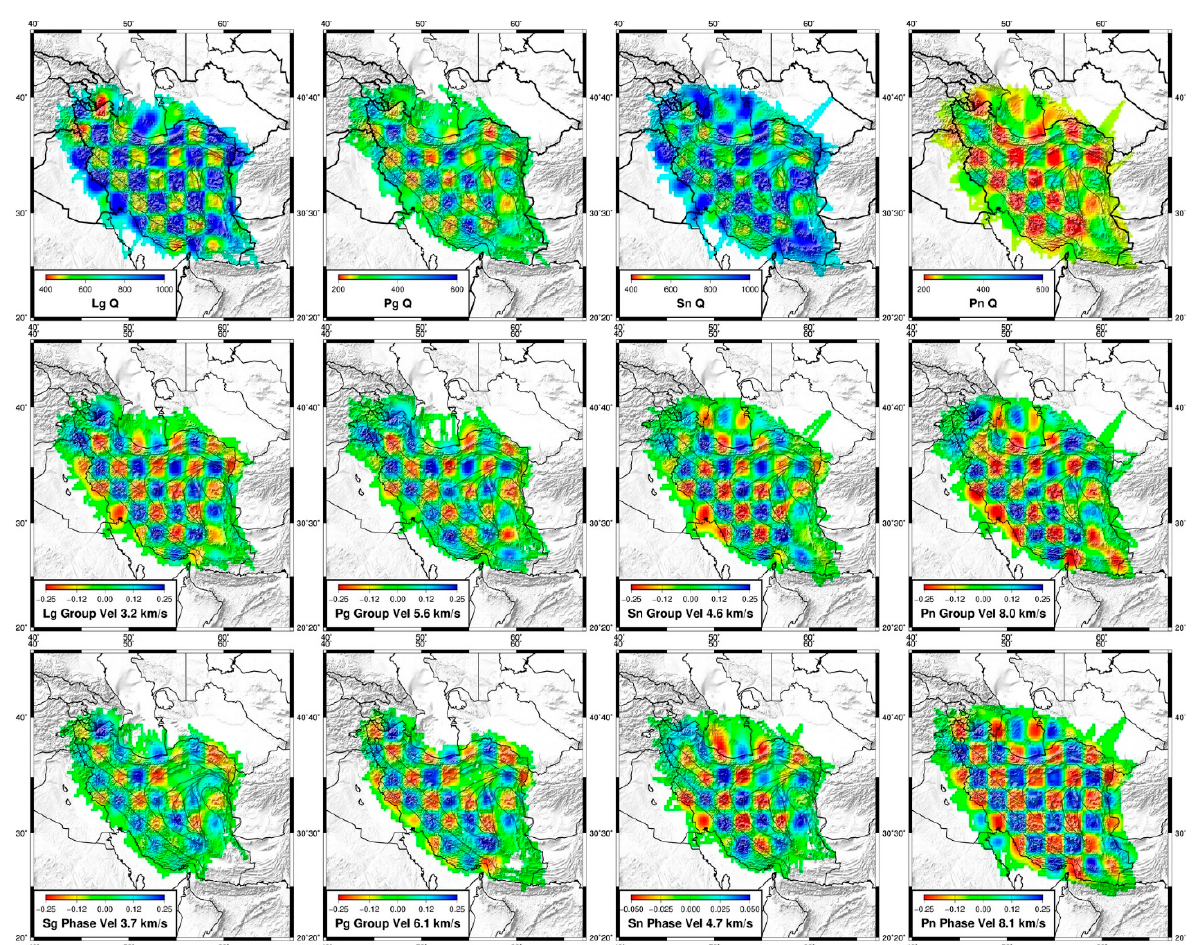
Figure 6. Checkerboard tests of velocity and attenuation. The original checkerboard had attenuation and velocity squares of two-by-two degrees. The station and event delays also alternated every two degrees. Representative noise was added. Velocity squares are ± 0.2 km/s and attenuation squares are ±150.